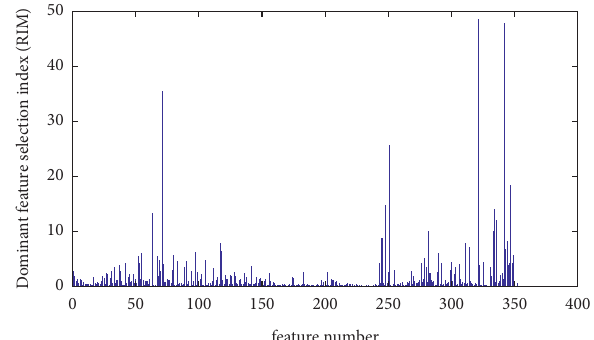
Figure 13: The dominant feature selection indexes of 352 features.